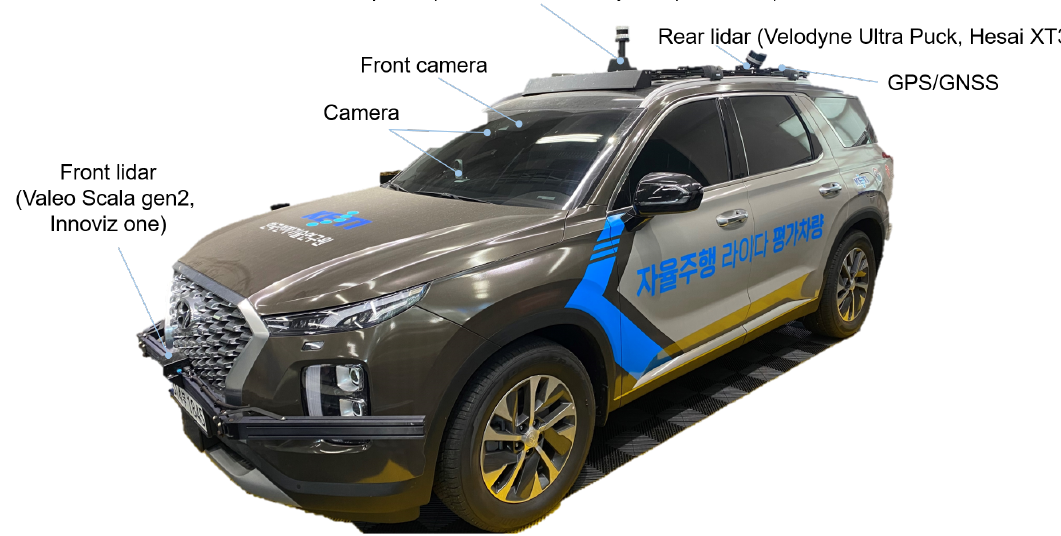
Figure 1. LiDAR test vehicle. Test devices are attached on Front, Top, and Rear positions using additional metal structures. At each position, the corresponding LiDAR sensors can be replaced and mounted as the DUT.